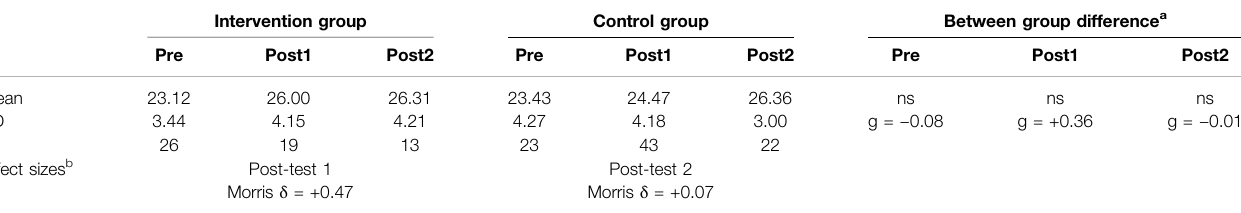
TABLE 6 | Teachers ’ collective ef fi cacy comparison between baseline, post-test 1 and post-test 2 (at the secondary